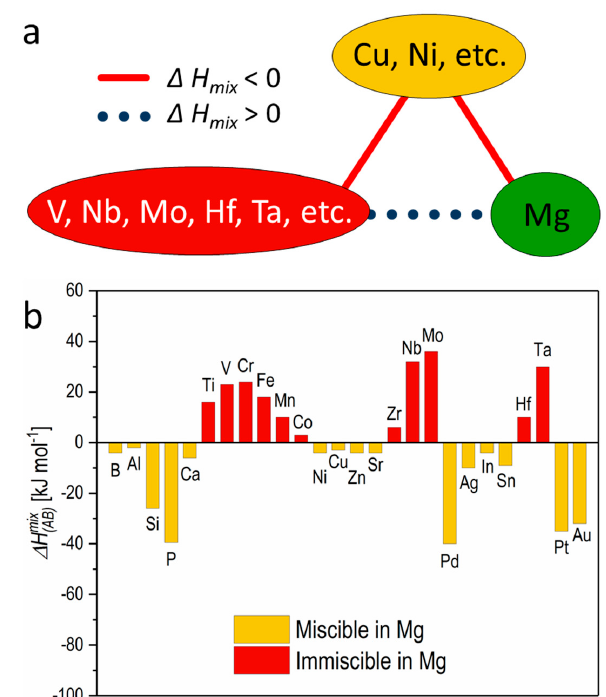
Figure 1. Selection of elements for liquid metal dealloying. ( a ) The values of ∆𝐻 ((cid:3002)(cid:3003))(cid:3040)(cid:3036)(cid:3051) (kJ/mol) calculated by Miedema’s model for atomic pairs between Mg and elements indicated in the plot [46]; ( b ) Required relationship of the values of enthalpy of mixing between elements for the liquid metal dealloying of a master alloy AB in a liquid metal C. Metals 2020 , 10 , x FOR PEER REVIEW